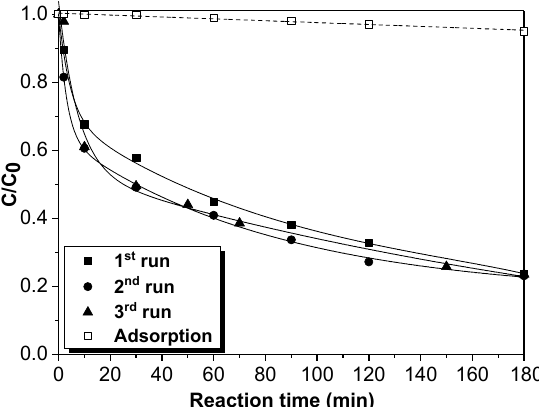
Figure 8. Performance of the catalyst upon three sequential runs of NAP removal by CPWO. Reaction conditions: [NAP] 0 = 10 mg/L, pH = 5, [catalyst] = 1.0 g/L, [H 2 O 2 ] 0 =2.5 mM, T = 70 °C.